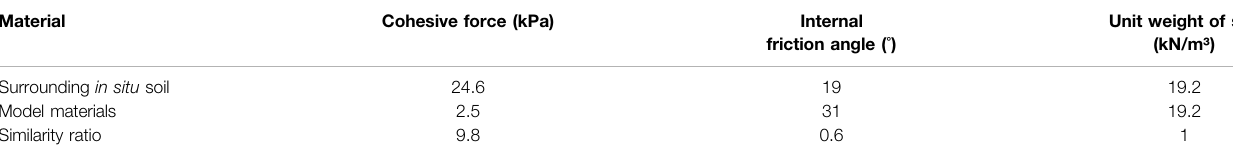
TABLE 3 | Surrounding in situ soil and model soil parameters.